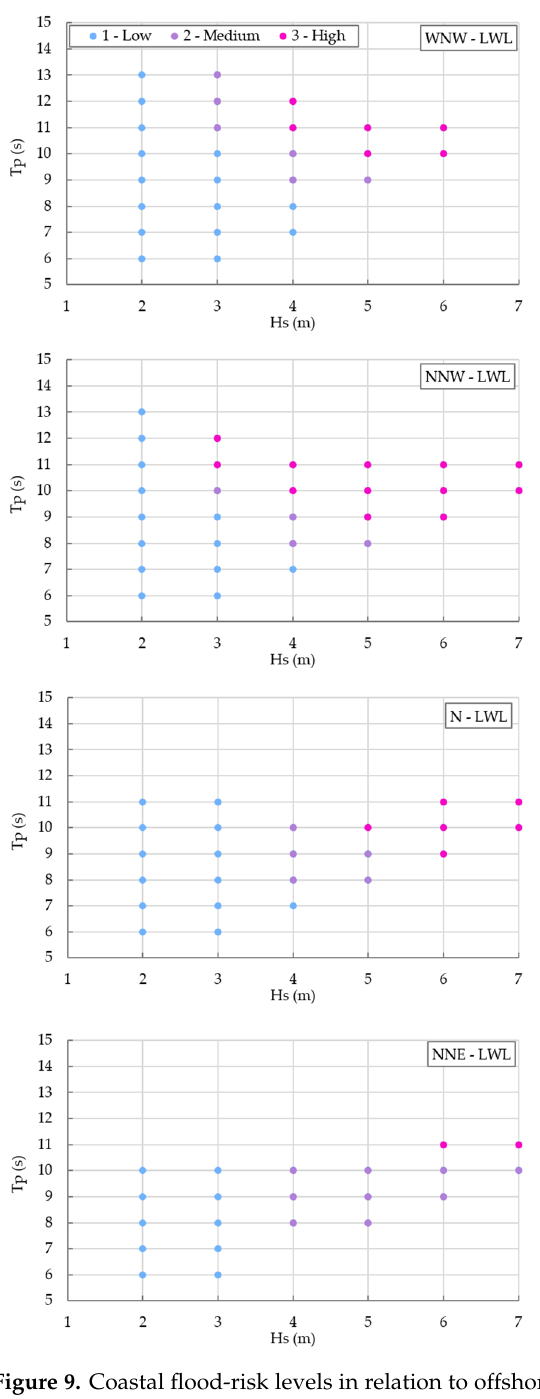
Figure 9. Coastal flood-risk levels in relation to offshore wave characteristics of selected distinct events, i.e., H s , T p and direction (WNW, NNW, N and NNE) and sea-water levels, i.e., LWL ( left panel ) and HWL ( right panel ), for the parking area. Light blue dots represent a low-risk level, purple represent a medium-risk level and pink represent a high-risk level.